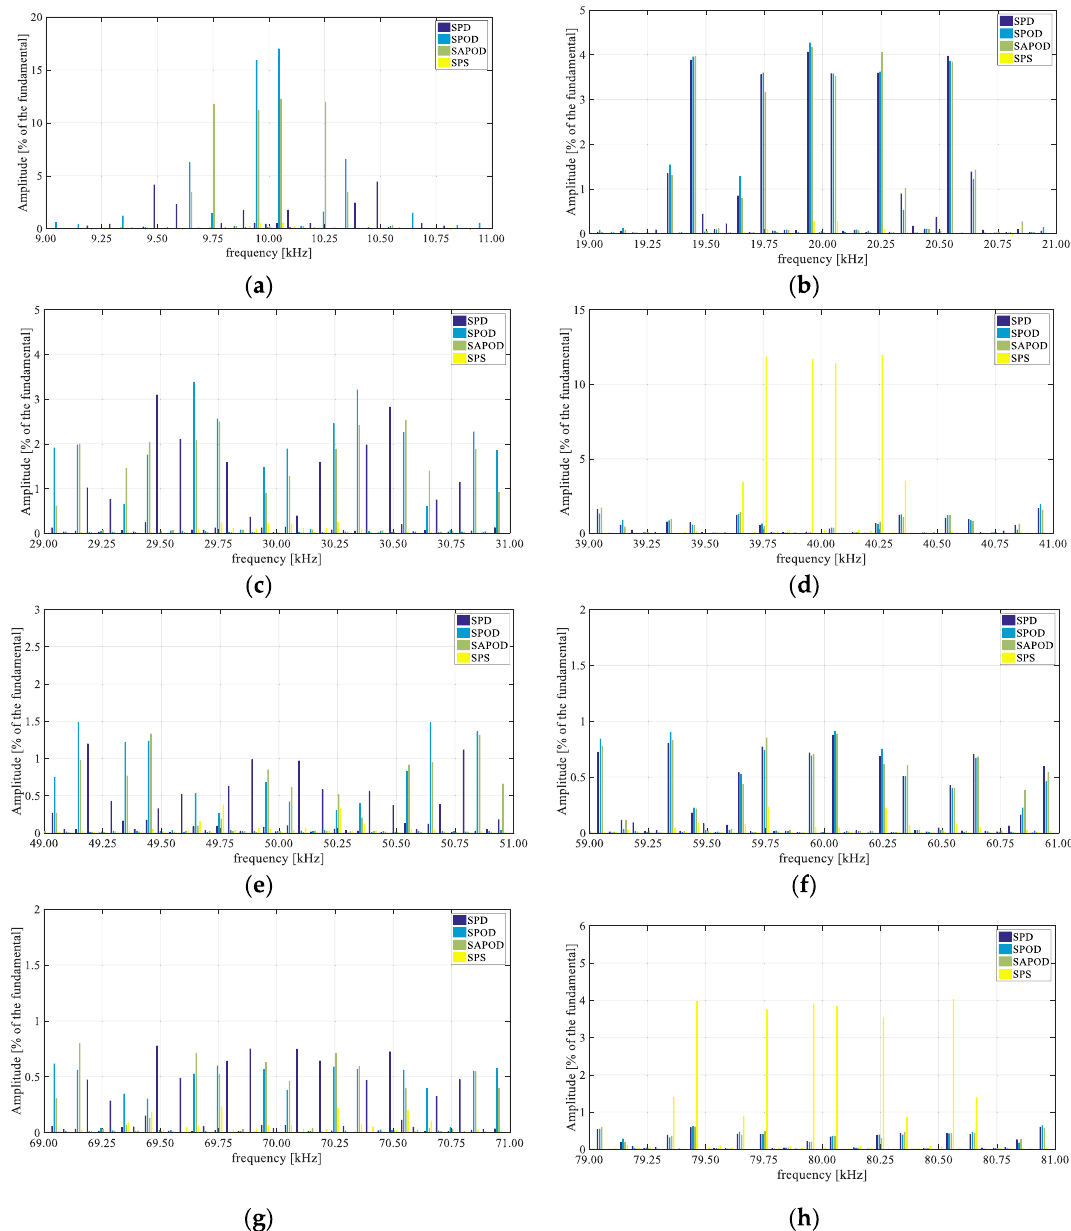
Figure 14. Comparison between the harmonic spectra around the center of multiples of the switching frequency for m equal to 0.9: SPD (blue bar), SPOD (light-blue bar), SAPOD (green bar) and SPS (yellow bar). ( a ) harmonic spectrum centered at 10 kHz; ( b ) harmonic spectrum centered at 20 kHz; ( c ) harmonic spectrum centered at 30 kHz; ( d ) harmonic spectrum centered at 40 kHz; ( e ) harmonic spectrum centered at 50 kHz; ( f ) harmonic spectrum centered at 60 kHz; ( g ) harmonic spectrum centered at 70 kHz; ( h ) harmonic spectrum centered at 80